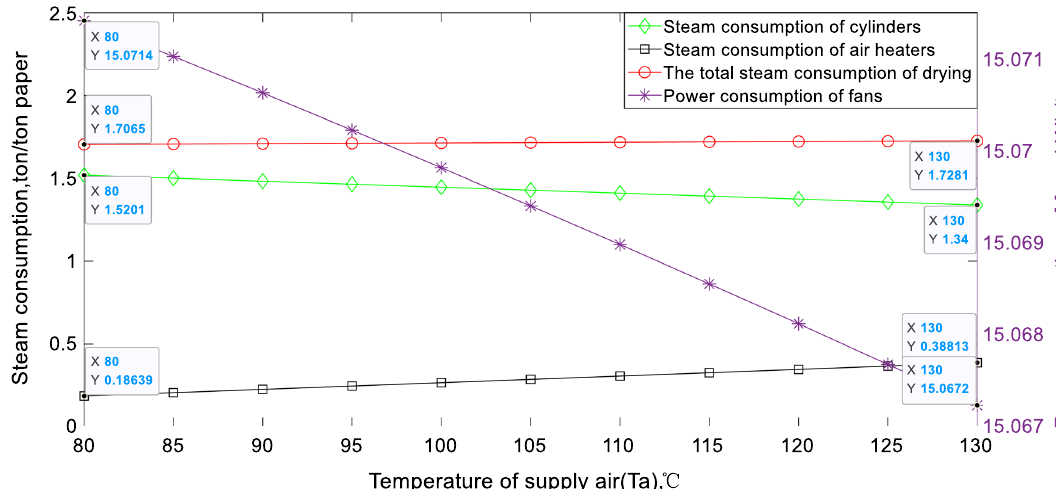
Fig. 8 Effect of air temperature on the energy consumption of drying